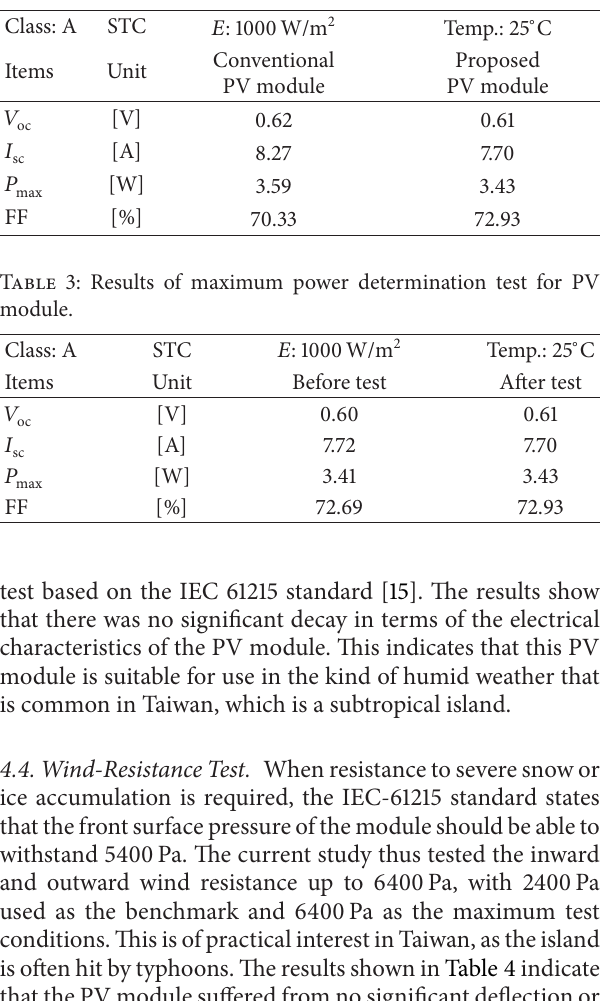
Table 2: Results of maximum power determination test.